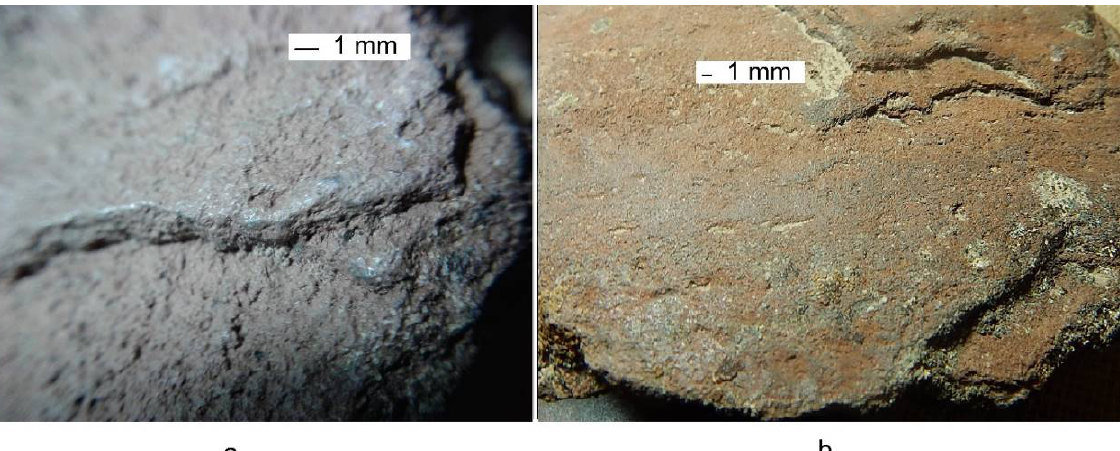
Figure 6. Specimen 6, (a) linear polish along a step-fracture scar, and (b) diffuse polish near the margin of the same tool. (Photographs by Steve Tomka.)